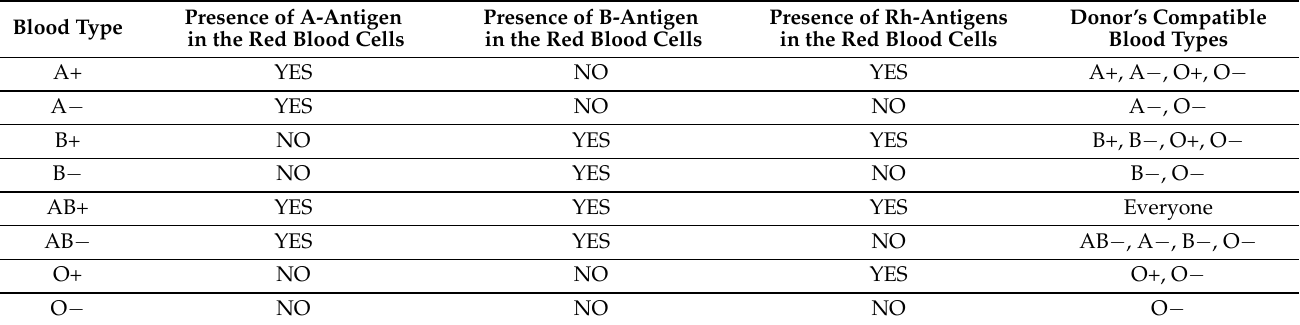
Table 1. Blood types and its compatibility with each other.